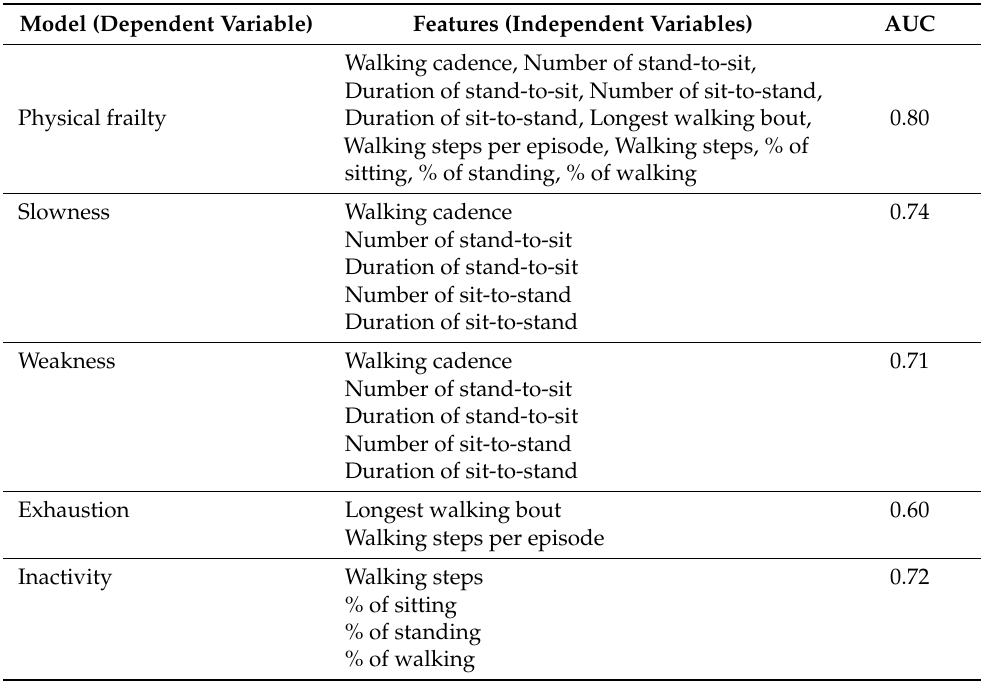
Table 4. Results of area-under-curve (AUC) for the physical frailty, slowness, weakness, exhaustion, and inactivity